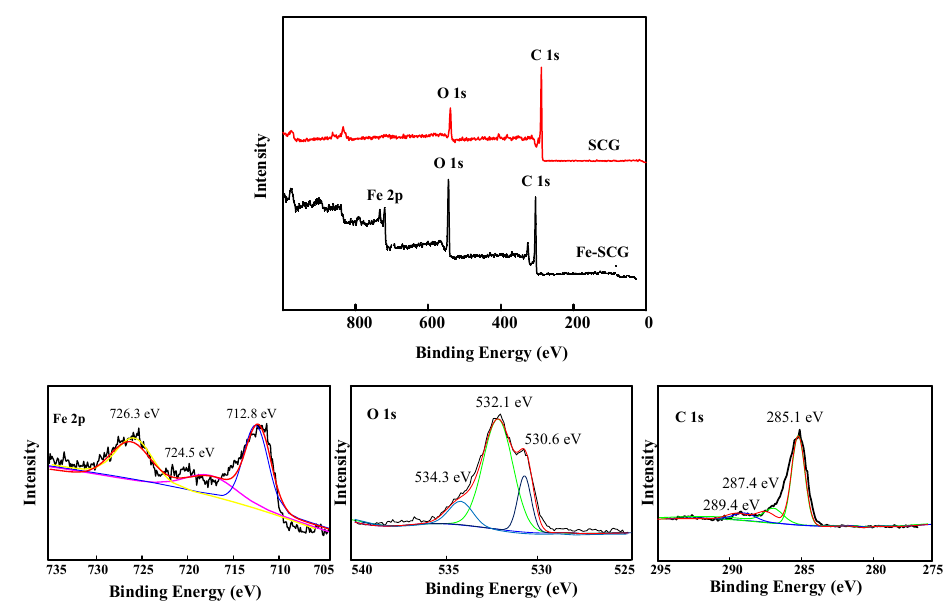
Figure 3. High-resolution X-ray photoelectron spectra (XPS) of SCG and Fe-SCG.